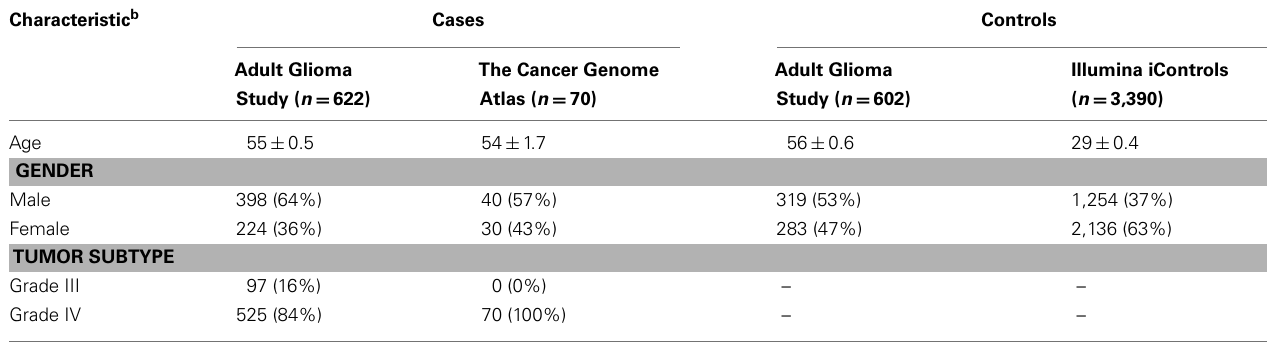
Table 1 | Discovery set subject characteristics a